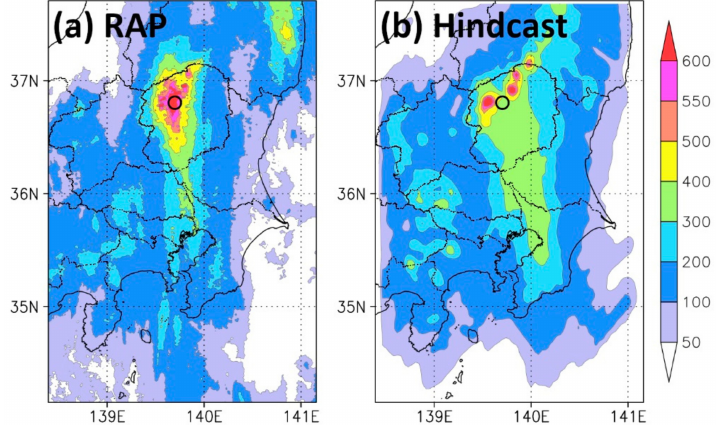
Figure 2. Total rainfall from 8 to 11 September 2015. ( a ) Result by Radar-AMeDAS precipitation (RAP); ( b ) ensemble mean total rainfall of the hindcast. Open circle indicates the location of the Nikko city. The unit of the color bar is mm.